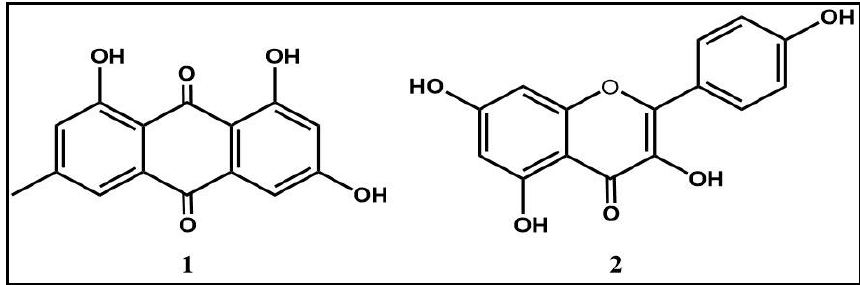
Figure 2. Chemical structures of emodin ( 1 ) and kaempferol ( 2 ) isolated from the leaves of R. alaternus .